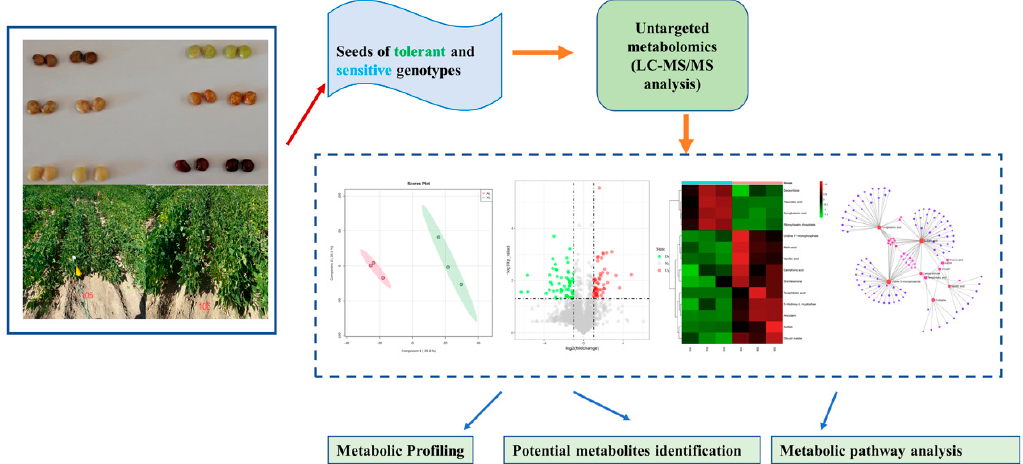
Figure 1. Overview of the untargeted metabolomic profiles of common bean